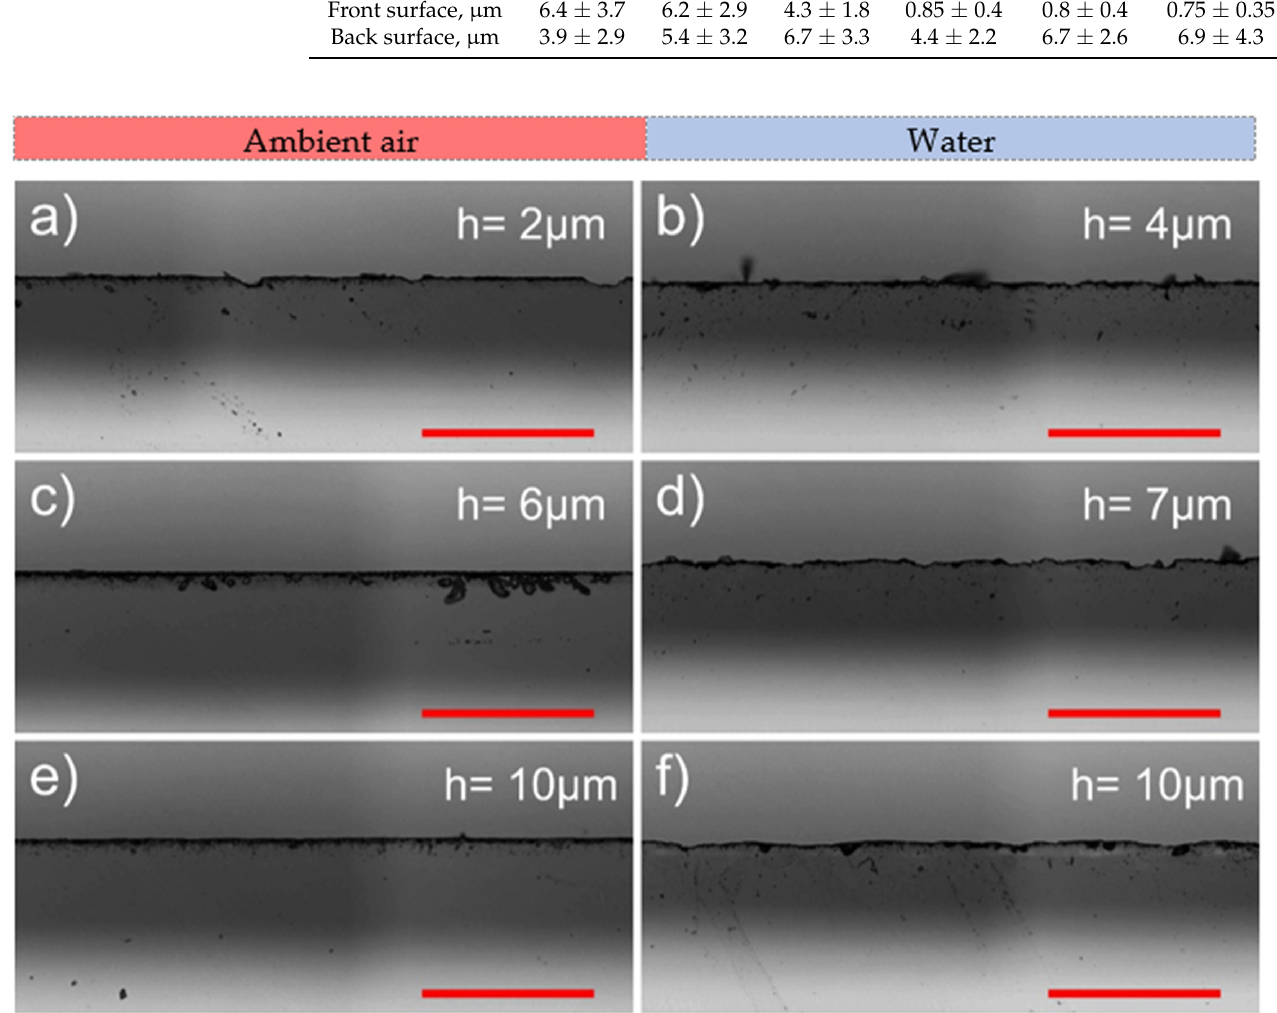
Figure 12. Optical micrographs showing cut edges at the back surface produced in ambient air (to the left) and water (to the right). Rows represent different pitch distances: ridge-free ( a , b ), intermediate ( c , d ), and optimal ( e , f ). The scale bars represent 200 µm and apply to all panels in the figure.